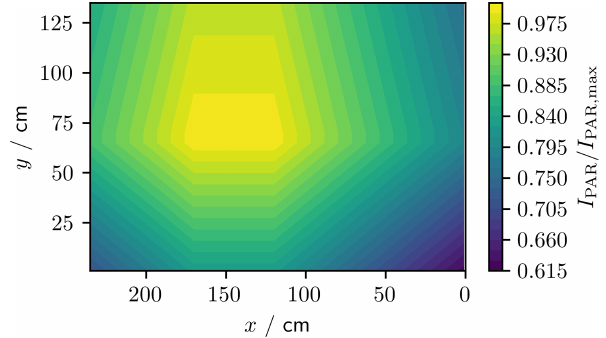
Figure 8. Normalised PAR ( λ = 400 to 700nm) irradiance across the footprint of the tank at 1m height. The (0, 0)cm coordinate corresponds to the pink asterisk in Fig.